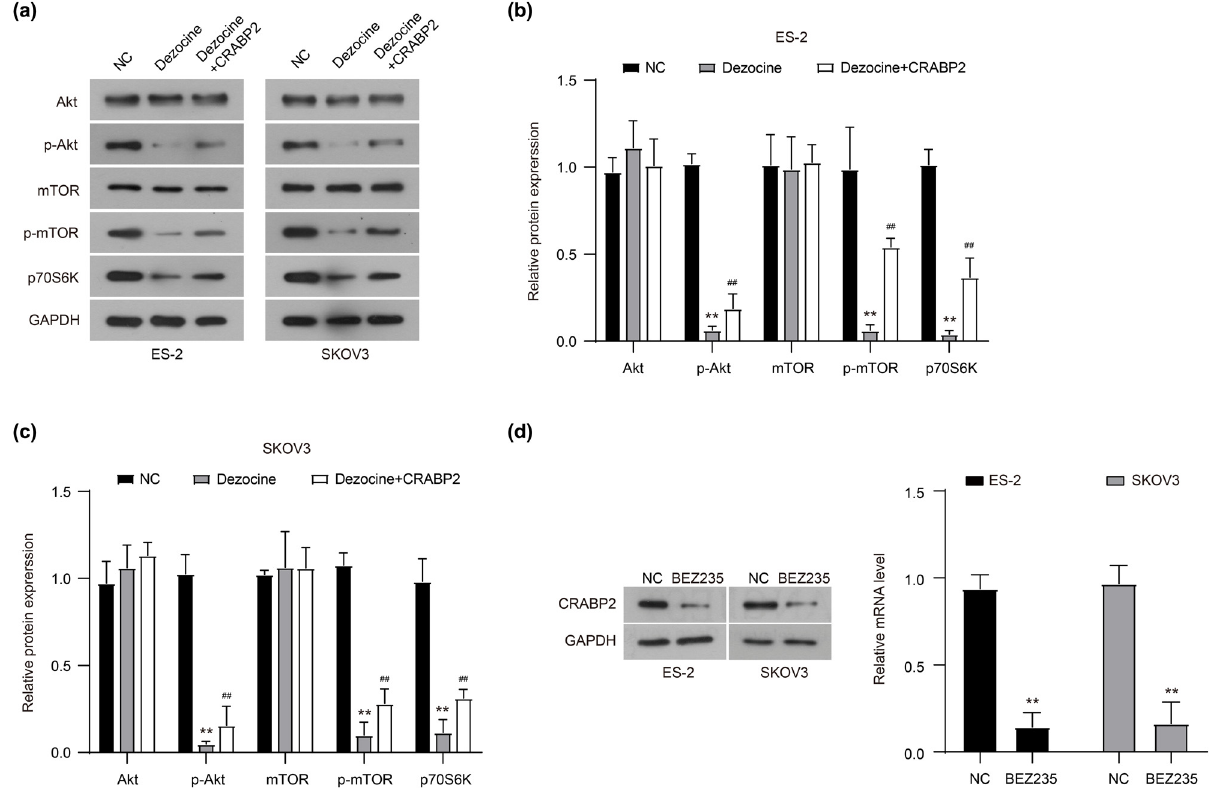
Figure 5: Dezocine inhibits CRABP2 expression by targeting the Akt/mTOR signaling pathway. ( a – c ) Expression of important components involved in the Akt/mTOR signaling pathway in ES - 2 and SKOV3 cells that were treated with dezocine and CRABP2 overexpression. ( d ) The protein expression of CRABP2 in ES - 2 and SKOV3 cells treated with BEZ235 ( 10 nM, a double - e ff ect inhibitor of AKT ) . ** P < 0.01, compared with NC group; ## P < 0.01, compared with Dezocine